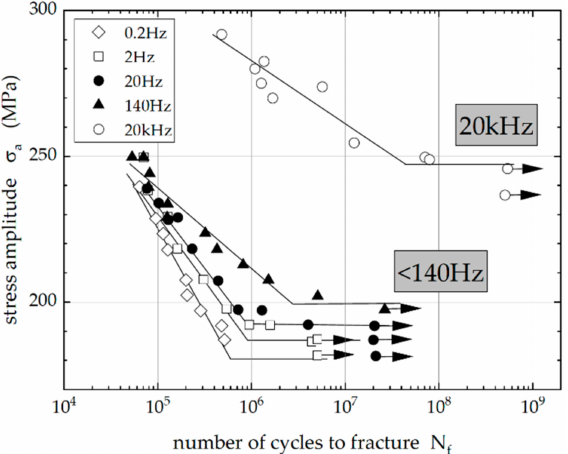
Figure 1. Wöhler S-N Diagram showing the fatigue life for C15 (0.15% carbon) steel at various testing frequencies